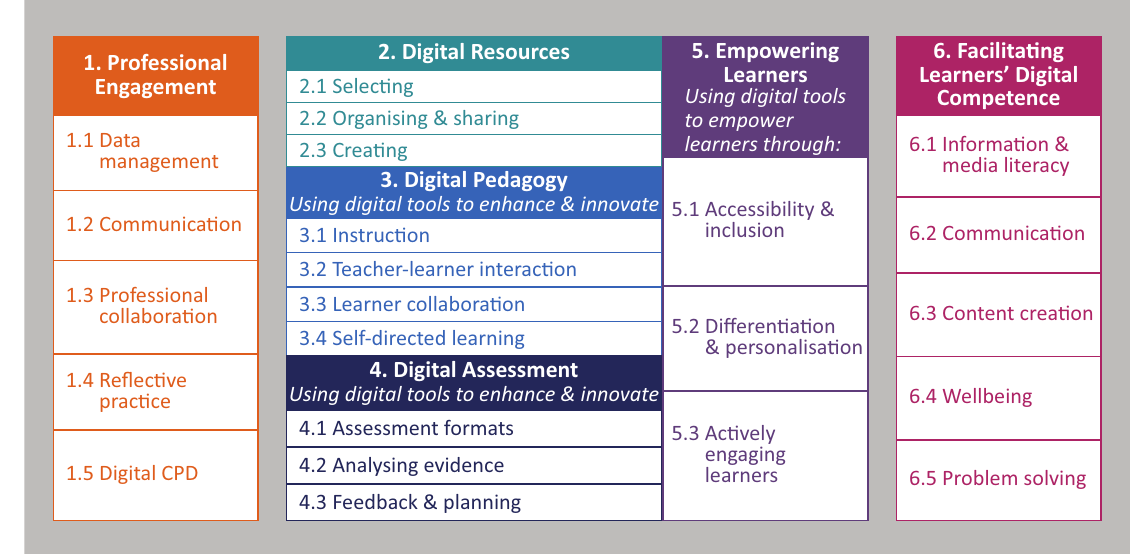
Figure 2. Overview of the digital competence in education framework. Source: Redecker